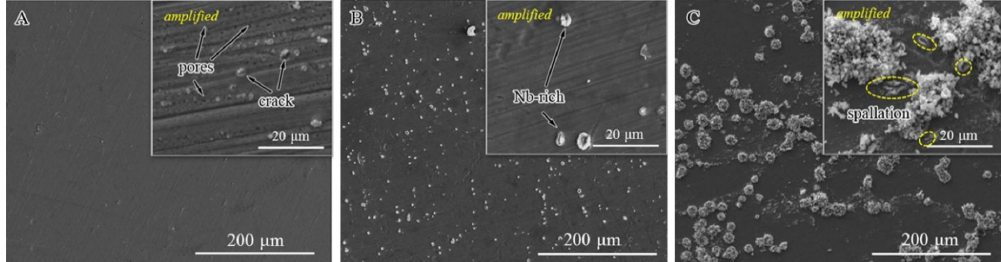
Figure 5. Surface morphologies of the alloys after oxidation in pure water vapor for the initial 50 h: ( A ) commercial HR3C alloy, ( B ) 1#HR3C alloy, and ( C ) 2#HR3C alloy. The cross-sectional microstructures of the commercial HR3C, 1#HR3C, and 2#HR3C alloys after